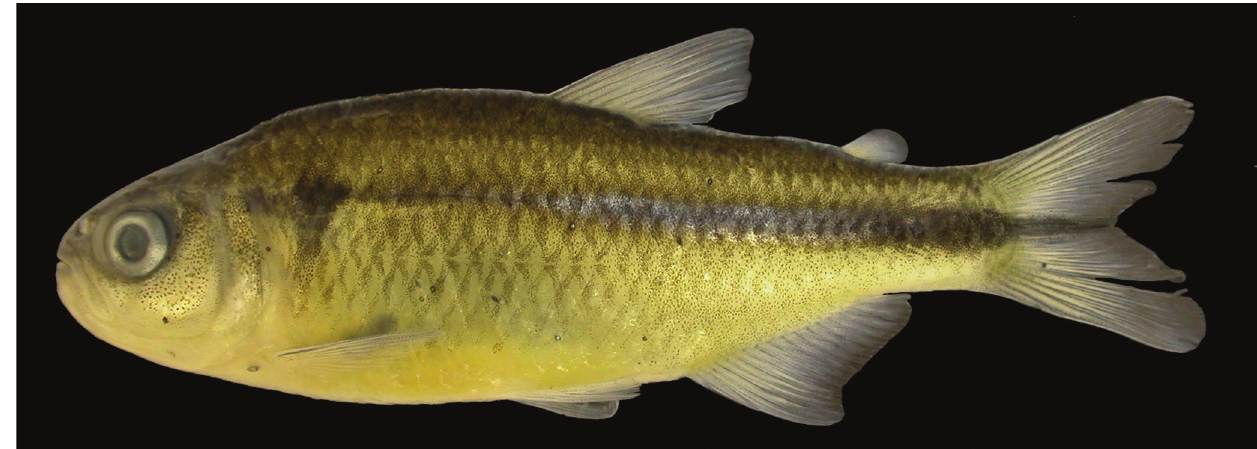
Fig. 5. Astyanax courensis , new species, UFRGS 11499, holotype, female, 54.2 mm SL; rio dos Couros at Parque Portal da Chapada, tributary of rio Tocantinzinho, upper rio Tocantins basin, Alto Paraíso de Goiás, Goiás State,